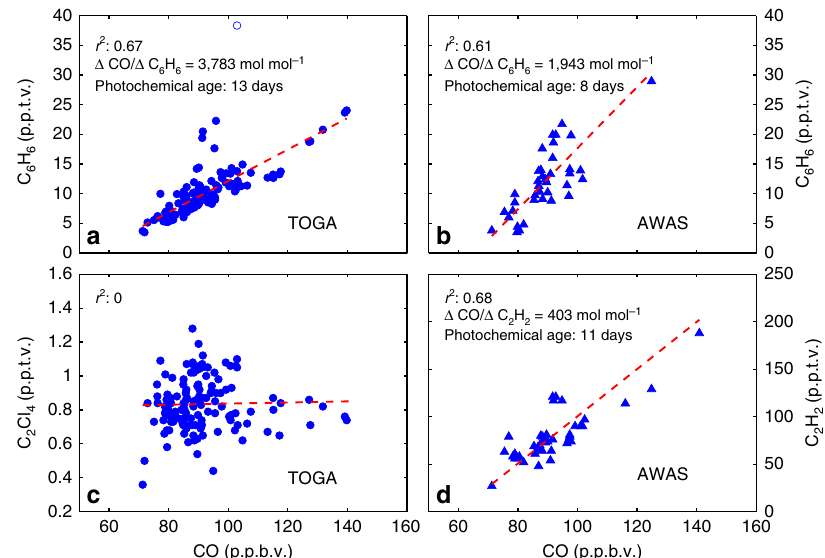
Figure 8 | Photochemical age of observed air parcels. Regression of CO against: TOGA C 6 H 6 ( a ); AWAS C 6 H 6 ( b ); TOGA C 2 Cl 4 ( c ); and AWAS C 2 H 2 ( d ). Data are only for the HOLW structures (O 3 4 40p.p.b.v. and RH o 20%). The dashed red line is the best fit via orthogonal linear regression. A single data outlier (open circle, a ) has been excluded from the analysis. Values of r 2 are shown for all panels; enhancement ratios and photochemical ages are shown for panels a , b and d . Excluding the data point for which C 6 H 6 4 25p.p.t.v. for panel b results in an r 2 of 0.47, a CO to C 6 H 6 enhancement ratio of 1,823molmol (cid:2) 1 , and a photochemical age of 7 days.